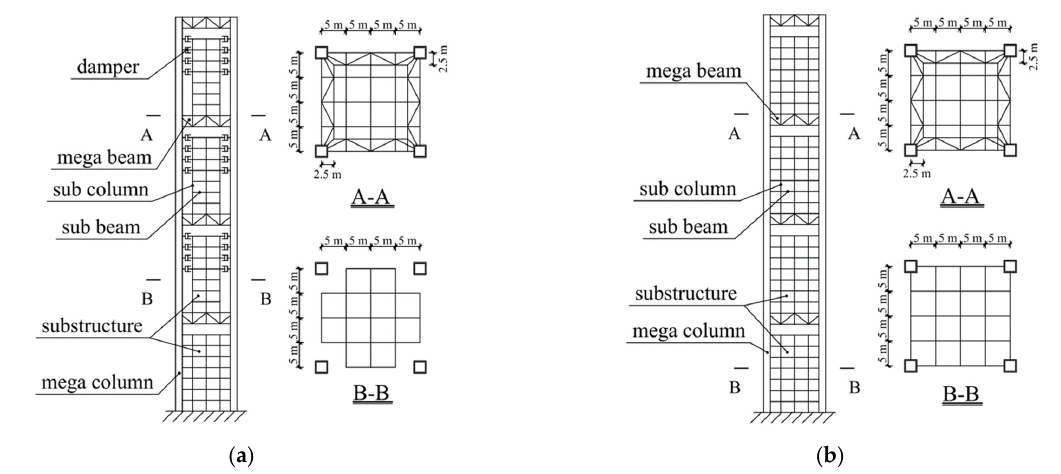
Figure 8. Schematics of MFS and MFVCS. ( a ) MFVCS. ( b ) MFS. Table 3. Member section information.